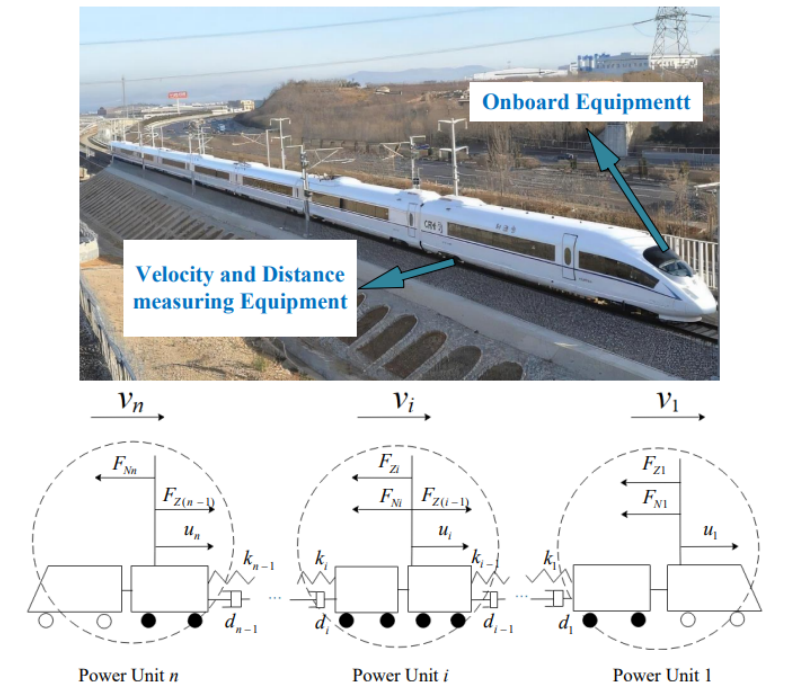
Figure 1. Dynamic description of EMUs operation